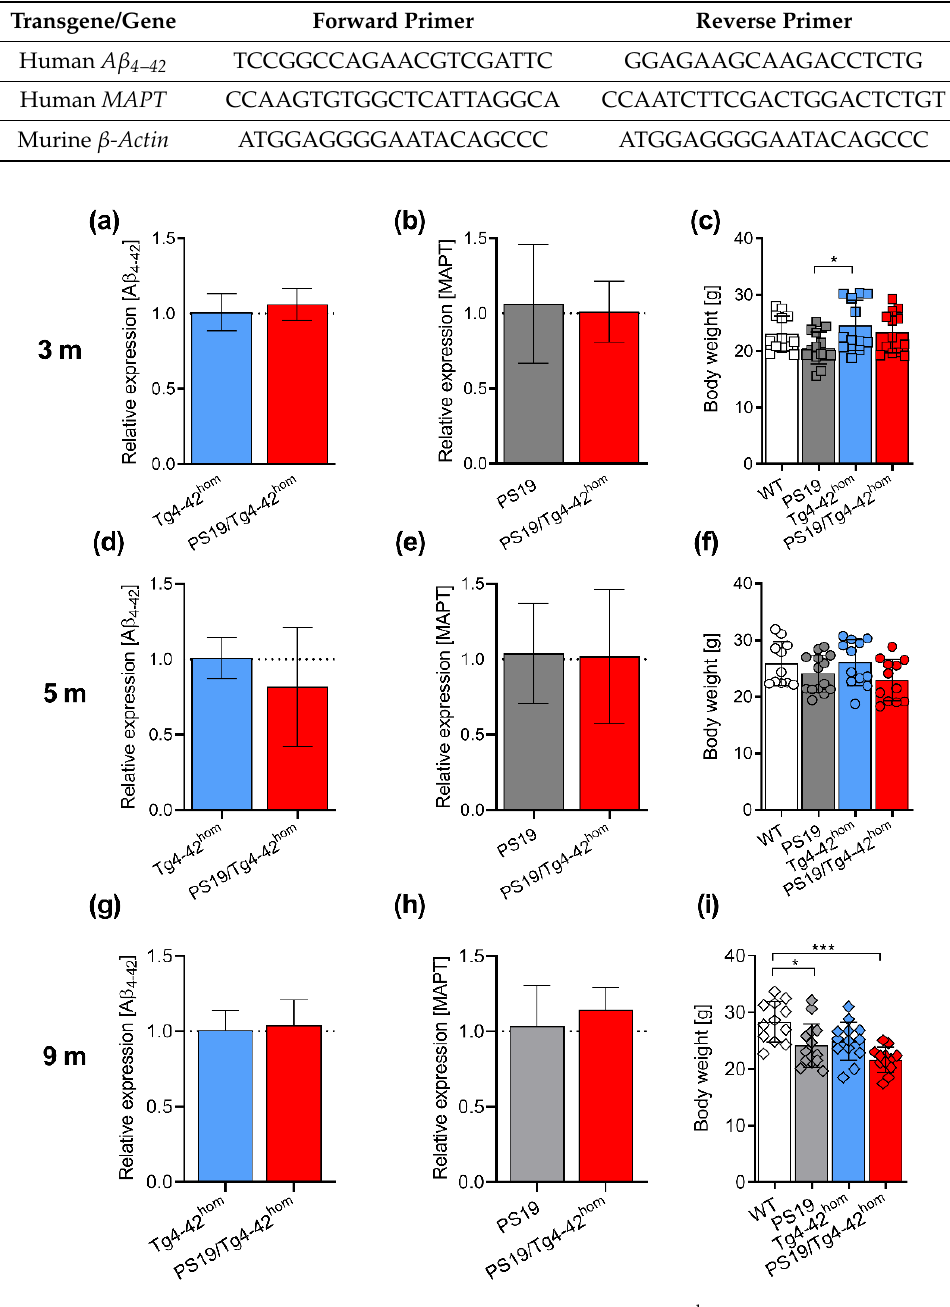
Figure 1. Transgene expression and body weight in PS19/Tg4–42 hom mice. Hippocampal mRNA expression of the A β 4–42 transgene ( a , d , g ) and human PS19 (MAPT) gene ( b , e , h ) were measured in PS19/Tg4–42 hom mice and compared to the ones of the parental lines ( n = 5–6). At the considered ages of 3 ( c ) or at 5 months ( f ), no changes in body weight were detected in the transgenic lines compared to WT controls, nor in PS19/Tg4–42 hom compared to PS19 or Tg4–42 hom mice ( n = 12–14). At 9 months, the body weight of PS19 and PS19/Tg4–42 hom mice was significantly reduced compared to WT controls ( i ). All data are given as mean ± SD. ( a , b , d , e , g , h ) Mann–Whitney test, ( c , f ) One-way ANOVA followed by Bonferroni’s multiple comparison: * p < 0.05, *** p < 0.001. 2.2. PS19/Tg4–42 hom Mice Display a Partial Worsening of Motor Performance at 5 Months of Age